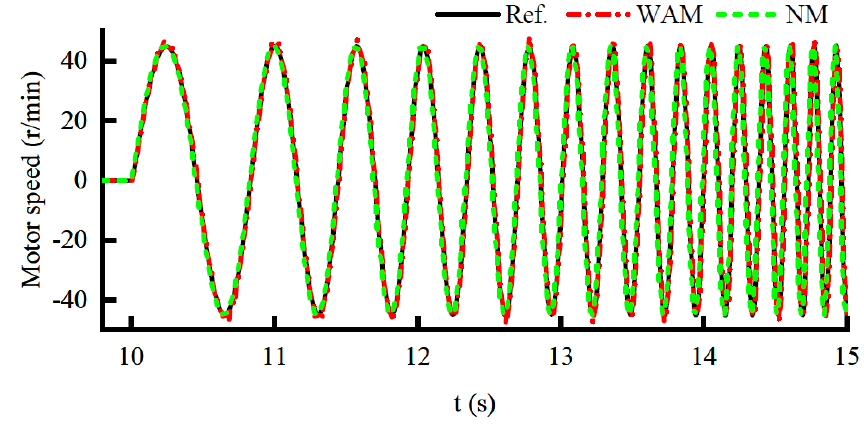
Figure 10. Response curve under nominal model and actual model.